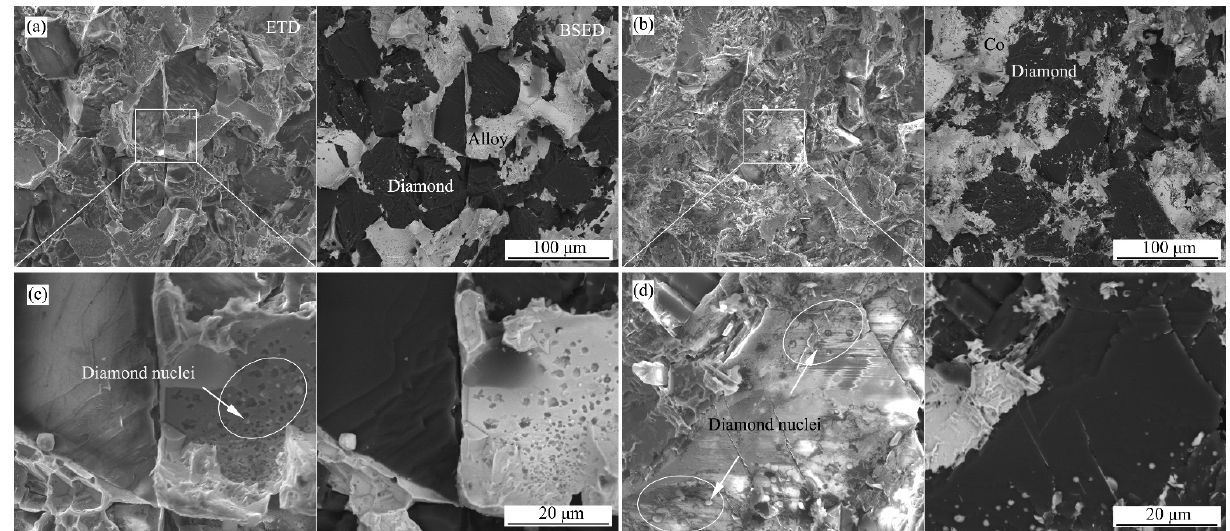
Figure 7. Secondary electron images (EDT, left half) and backscattered electron images (BSED, right half) of fracture morphologies of Co 50 Ni 40 Fe 10 -Comp ( a , c ) and Co-Comp ( b , d